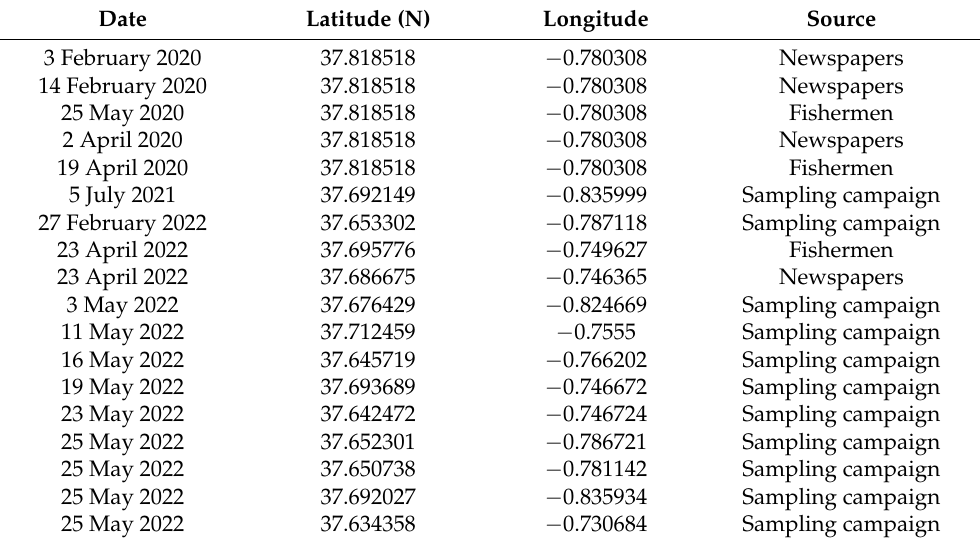
Table 1. Summary of the in situ data with the date and the location of the macroalgae